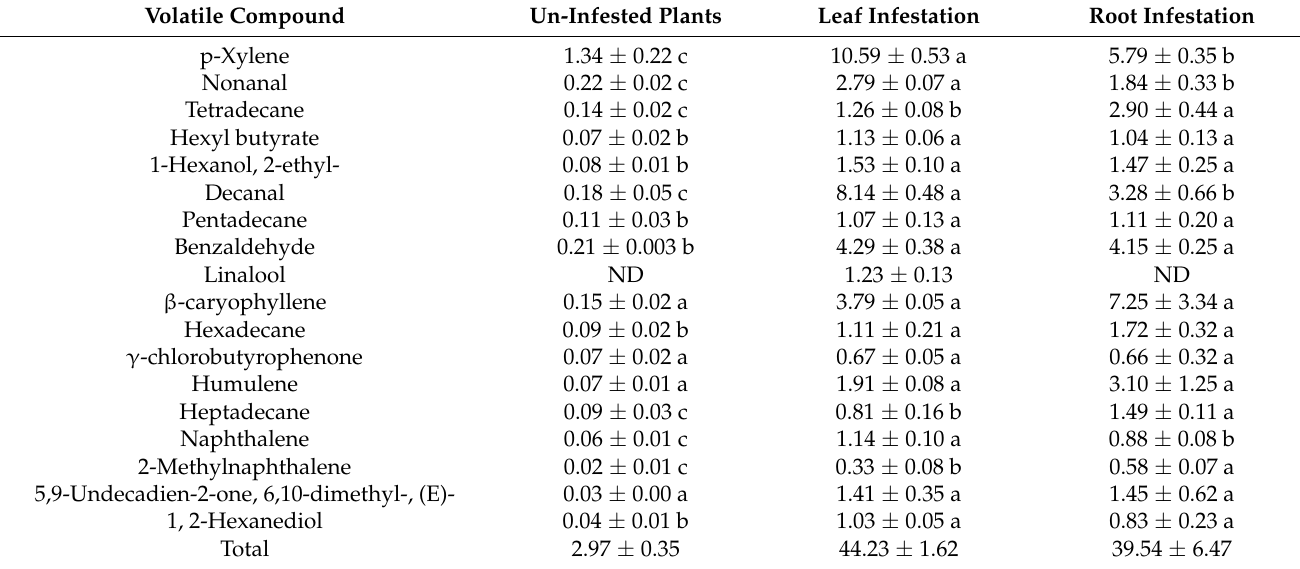
Table 1. Concentration of volatile compounds collected from cotton plants after infestation by A. segetum larvae.